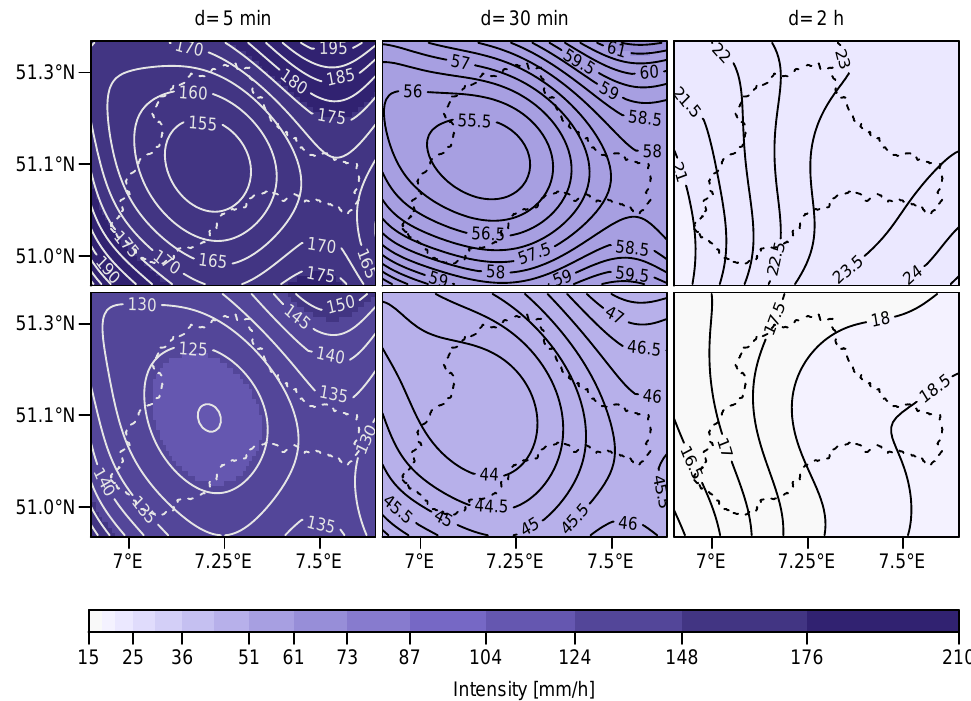
Figure 7. Point-wise return level maps for durations d ∈ { 5,30,120 } min (different columns) and probabilities p = 0.99 (upper panel) and p = 0.95 (lower panel) corresponding to return periods of 100 years and 20 years, respectively. The colors are provided as a general reference between the